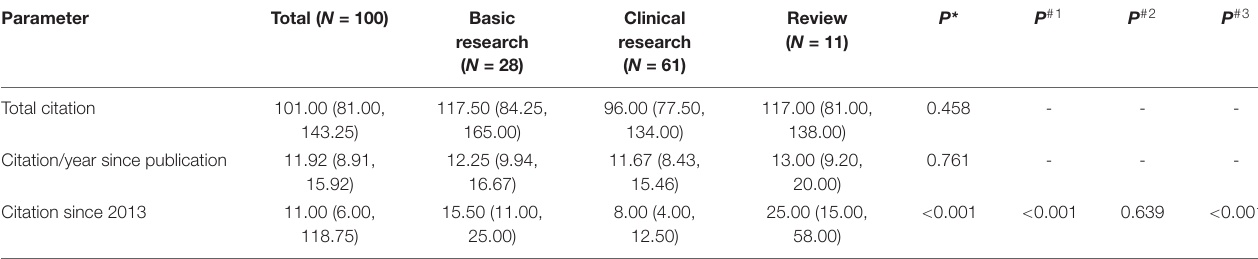
TABLE 1 | Citations comparisons according to type of article, median (P25,